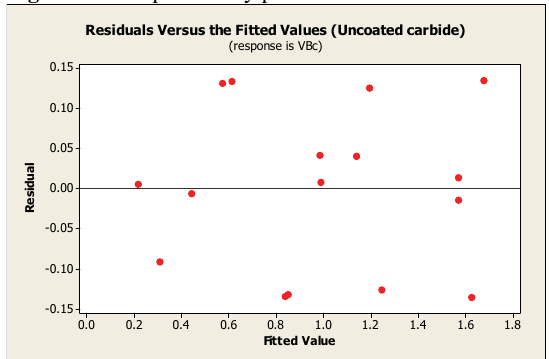
Fig. 8. Normal probability plot for flank wear Fig. 9. Normal probability plot for surface roughness